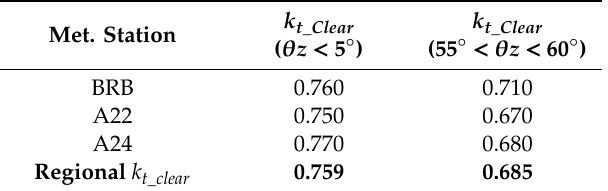
Table 6. List of ground measurement sites near the Serra da Mesa Reservoir used to estimate the cloudless atmospheric transmittances k t _ clear values. The simple model, described in Equation (7), provided the k t _ clear values for 5-degree intervals of solar zenith angles. The table presents the results for two of the intervals. The last line exhibits the results obtained by using data from the three measurement sites altogether to estimate regional k t _ clear